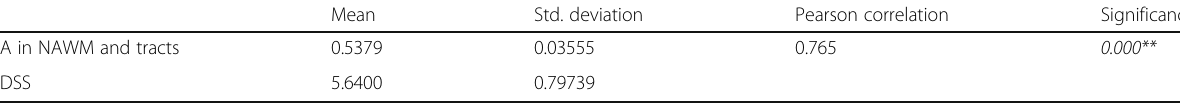
Table 3 Correlation between average FA in NAWM and tracts and EDSS in secondary progressive group Mean Std.